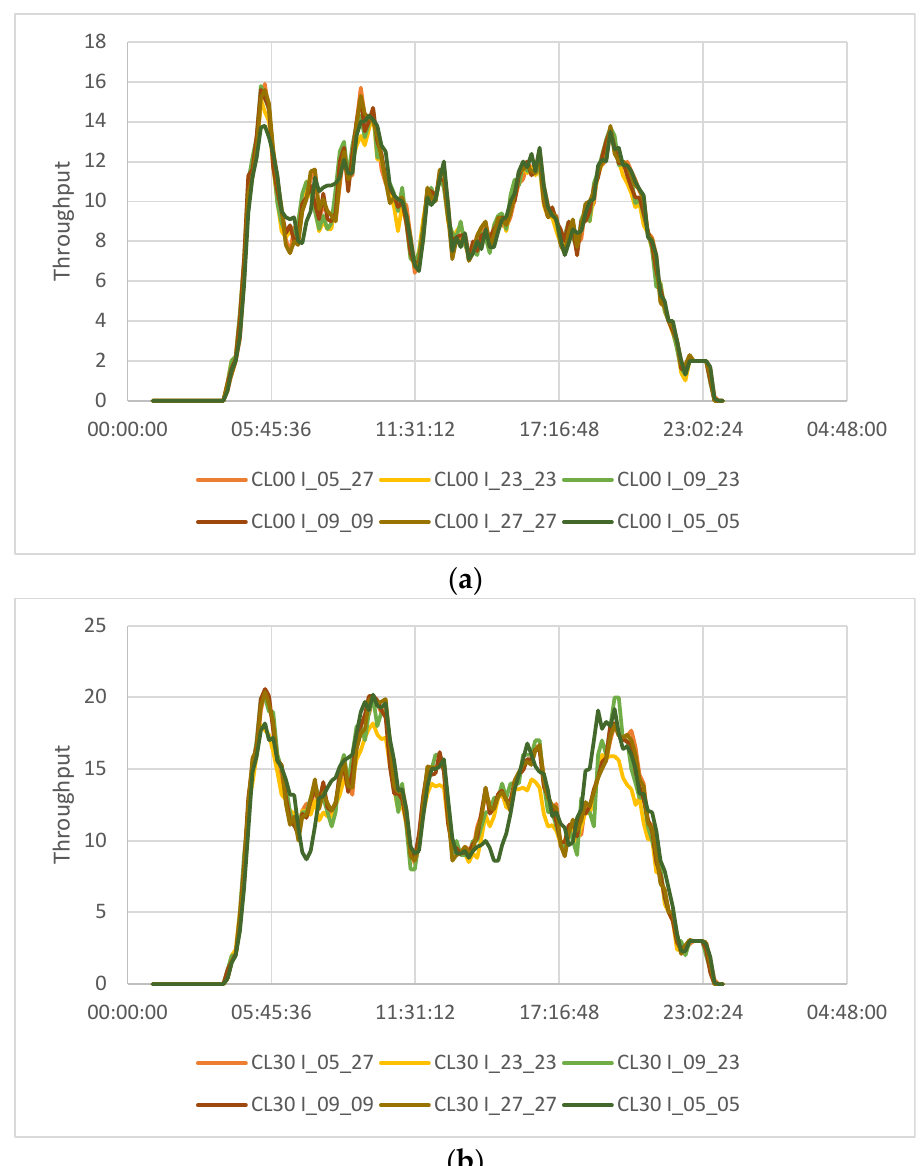
Figure 8. Comparison of throughput for all scenarios ( a ) CL00; ( b ) CL30 .